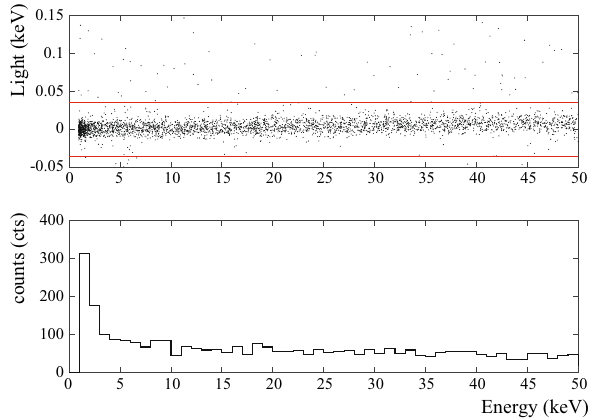
Fig. 3 Top: the light measured in coincidence by the LD (y axis) is displayedagainsttheenergydepositedintheLi 2 MoO 4 crystal(xaxis)in the ROI (1–50 keV). The two lines in solid red correspond to the values chosen for the anti-coincidence cut: the events which fall inside the two lines are accepted for the dark matter analysis. The rejected events show an excessive light signal, which cannot be attributed to single particle hits in the main absorber. Bottom: measured energy spectrum of the selected events. Those events can mainly be attributed to low energy